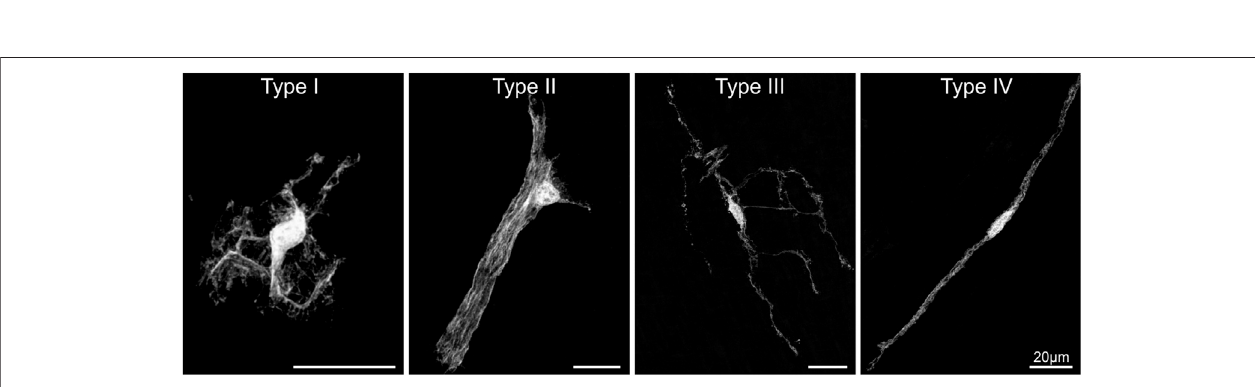
FIGURE 2 | The morphological enteric glial cell subtypes. Individual enteric glial cells with GFP labelling throughout their cell body to visualise their morphology. Sparse labelling of individual cells was achieved using the Sox10-cre;MADM transgenic mouse system. Adapted from (Boesmans et al., 2015).